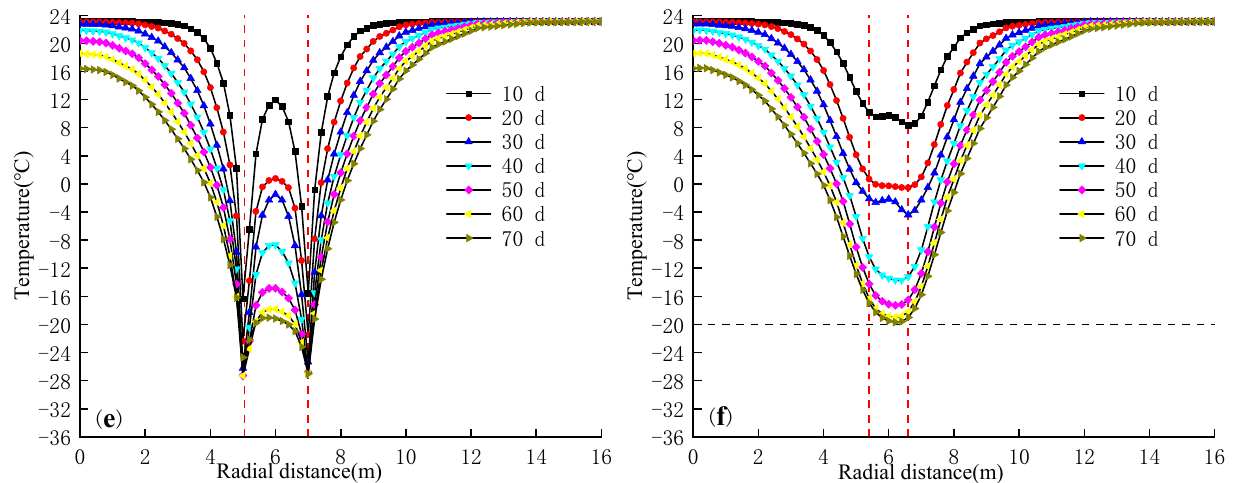
Figure 7. Temperature field distribution at the main surface and interface. ( a ) The − 120.5 m fine sand main surface. ( b ) The − 120.5 m fine sand interface. ( c ) The − 190 m clay main surface. ( d ) The − 190 m clay interface. ( e ) The − 216 m sandy clay main surface. ( f ) The − 216 m sandy clay interface.